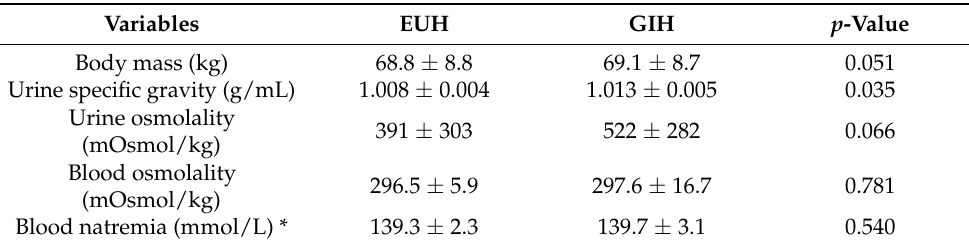
Table 1. Physiological variables and urine and blood markers of the participants at their arrival at the